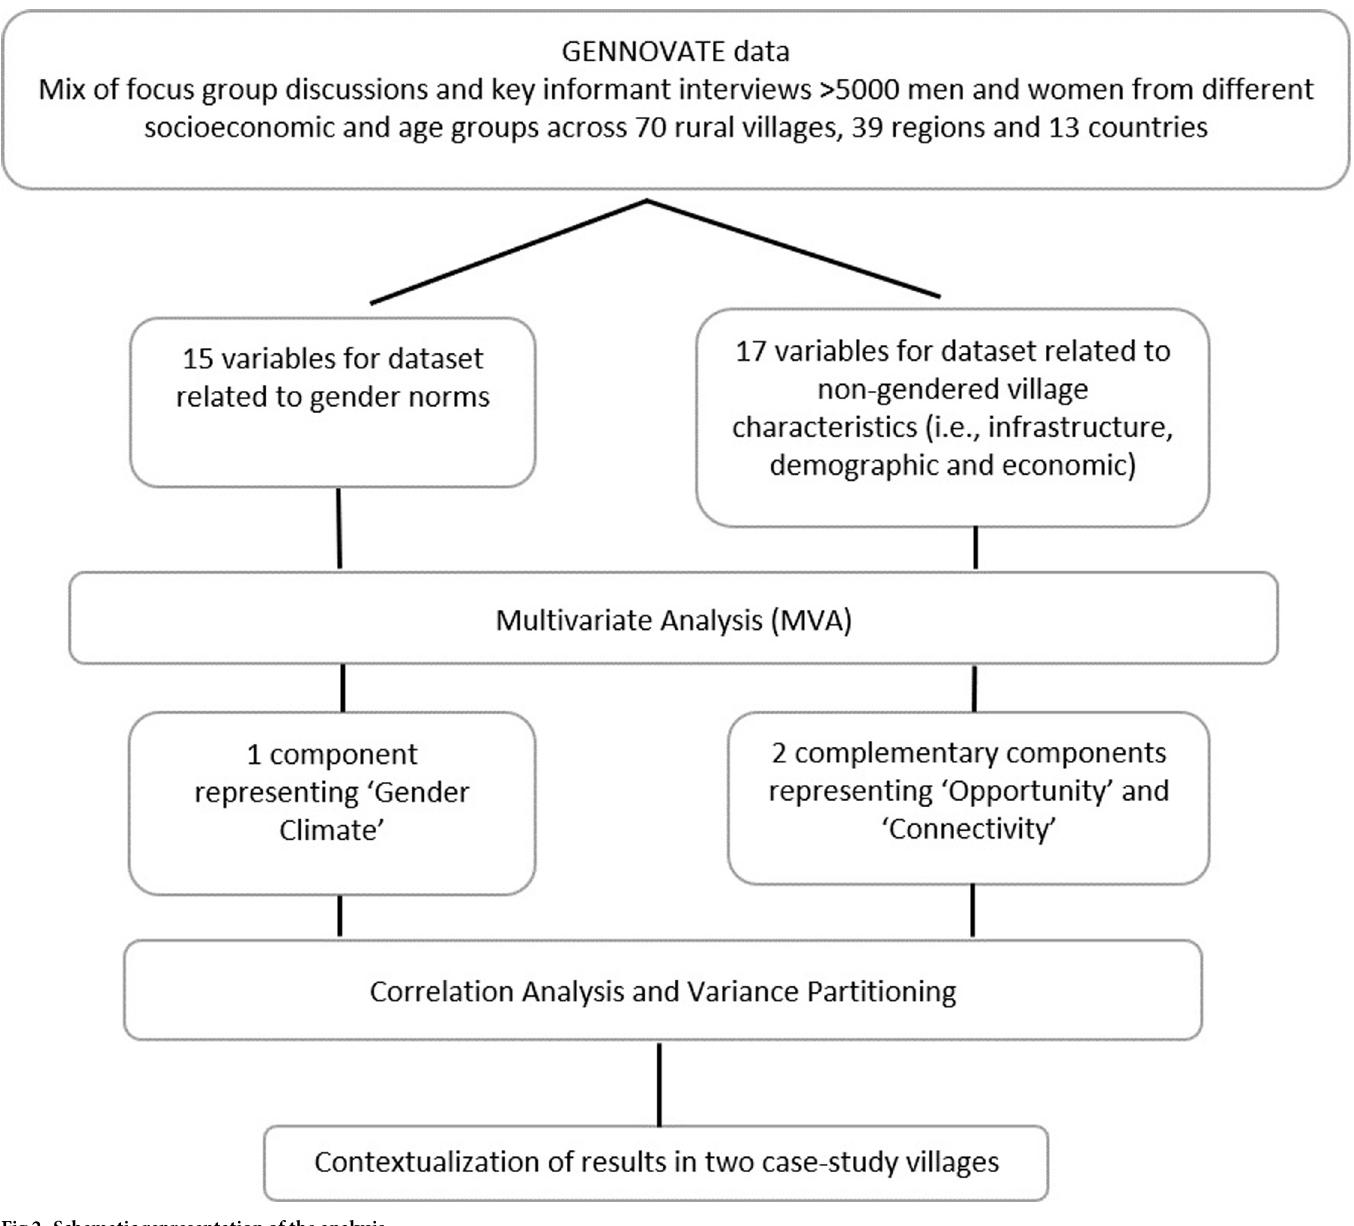
Fig 2. Schematic representation of the